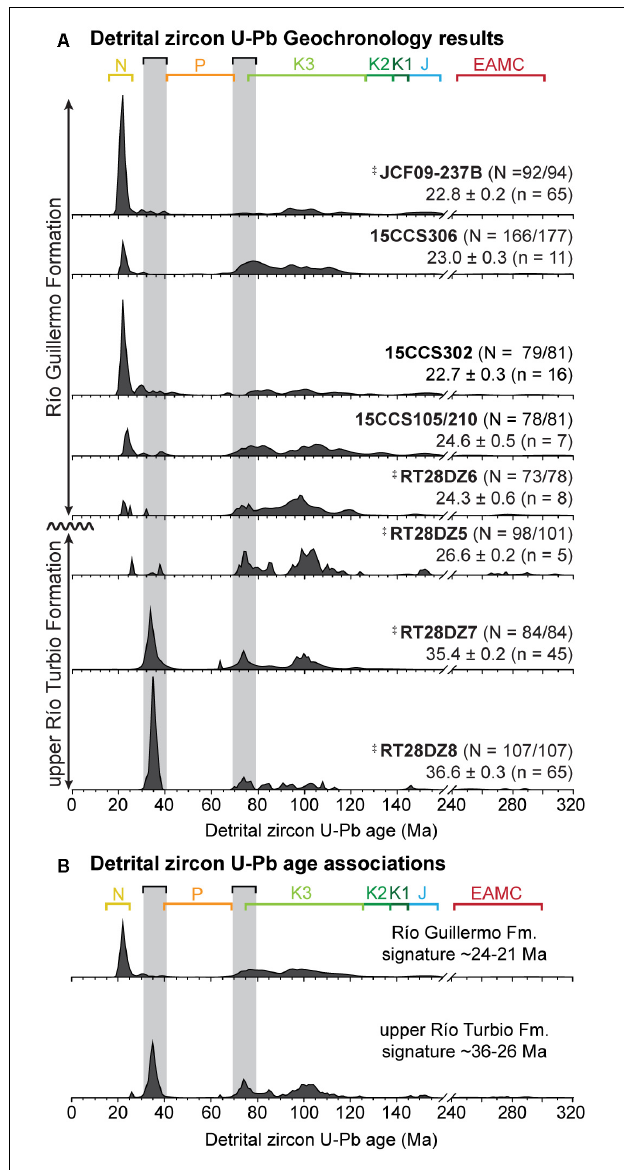
FIGURE 6 | Detrital zircon U-Pb LA-ICP-MS data showing upsection changes in provenance. (A) Normalized probability age distributions from the Río Guillermo and upper Río Turbio formations. Note the change in scale at 160 Ma. Ages of igneous sources as reported from Hervé et al. (2007) are Neogene (N), Paleogene (P), Cretaceous I (K1), Cretaceous II (K2), and Cretaceous III (K3), Jurassic (J), and Eastern Andean Metamorphic Complex (EAMC). (B) Combined detrital zircon age associations for the pre-tectonic and post-tectonic sediment sources, showing a loss of a predominant 30–40 Ma source prior to 24 Ma. ‡ denotes samples from Fosdick et al. (2019).